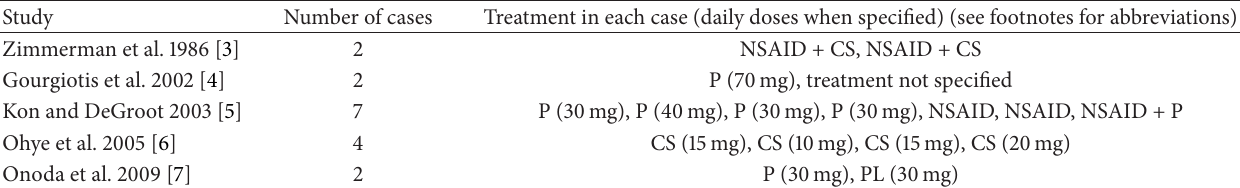
Table 2: Seventeen patients with PHT reported in the literature, who underwent thyroidectomy for thyroid pain resistant to medical treatment: treatment schedules before